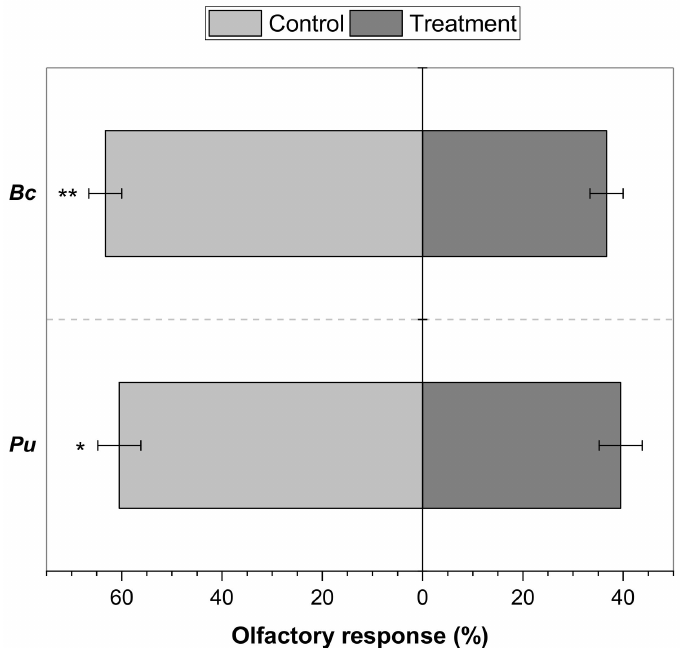
Figure 1. Olfactory response of horn flies to B. cruckchanksii leaves and P. uviferum heartwood EOs. Values indicate the mean + SE. Asterisks on the bars indicate significant differences between